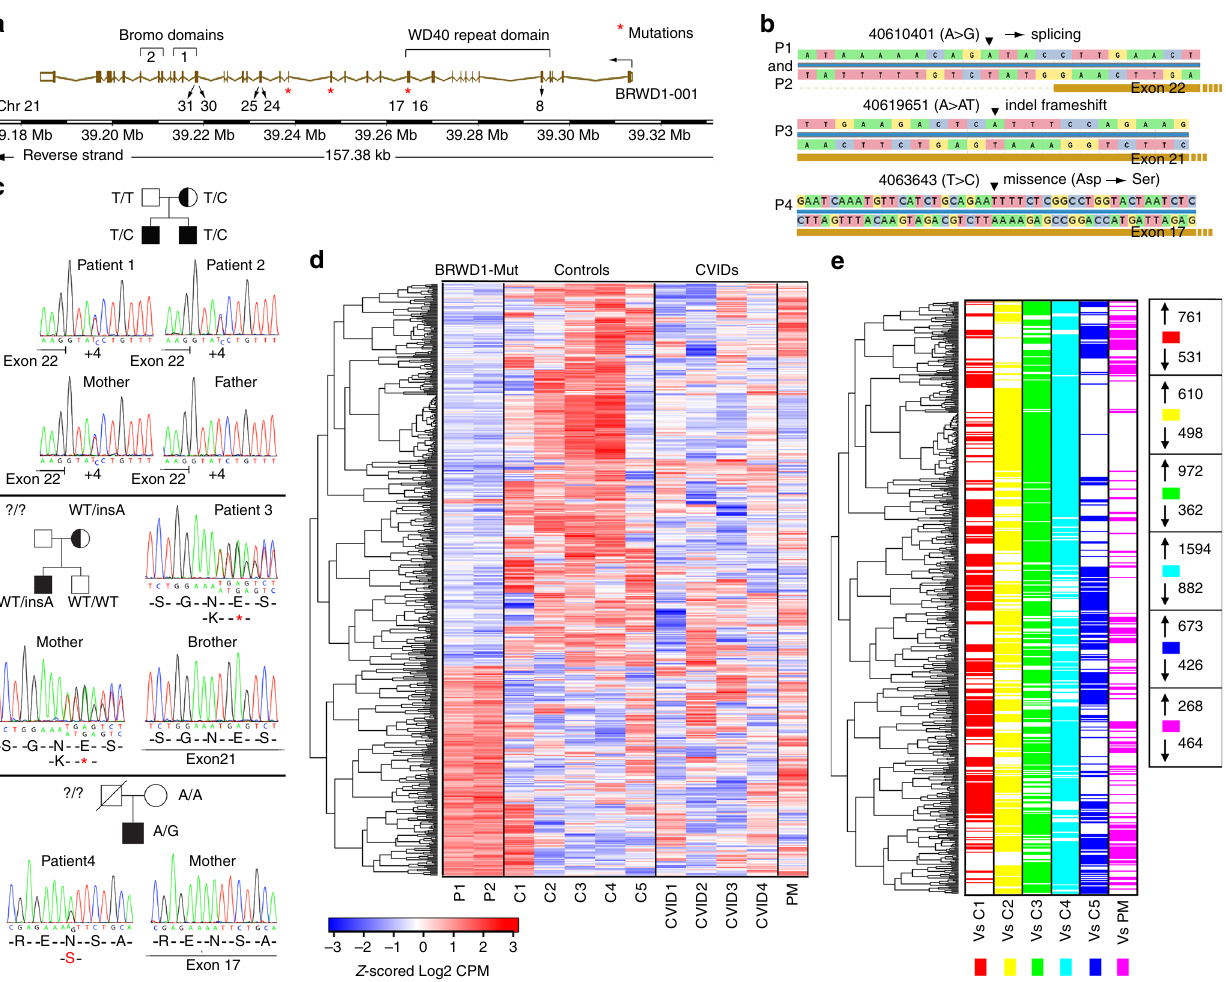
Fig. 5 BRWD1 mutations in human hypogammaglobulinemia. a Human BRWD1 with patient mutations (*) and exons encoding WD40 and bromo domains noted. b Details of the mutations in BRWD1 locus of hypogammaglobulinemic patients. c Sanger sequencing con fi rming the mutations in BRWD1 locus in chromosome 21 of idiopathic hypogammaglobulinemia patients compared to their healthy relatives. d Hierarchical clustering of differentially expressed genes identi fi ed at q < 0.05. EBV-transformed cell lines from controls (C), CVID patients, patients (P) or patients ’ mother (PM) shown. e Pairwise comparison of gene expression in patients vs. indicated controls or PM. The number of genes up ( ↑ ) and downregulated ( ↓ ) in each comparison